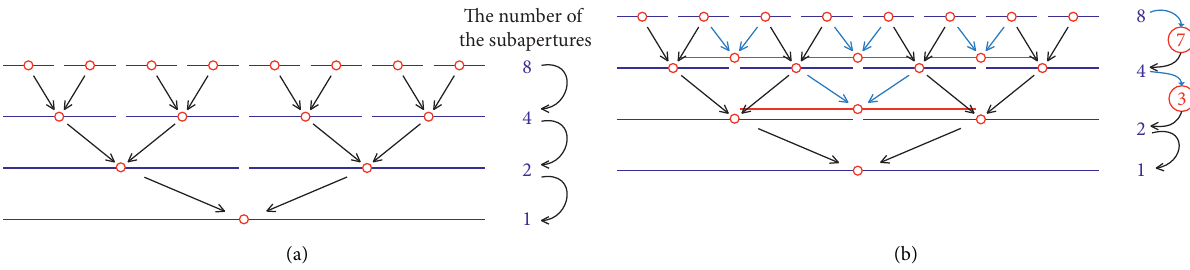
Figure 3: Change of the subapertures in the last four stages. (a) The original FFBP. (b) OSF in the modified